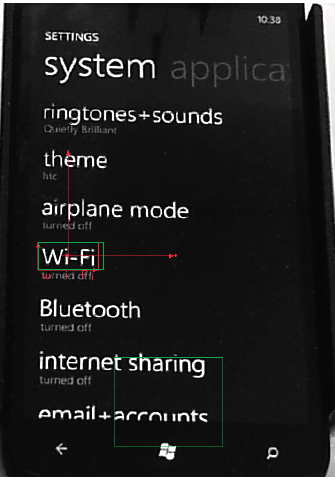
Figure 17. Recognition result with red characters: “Wi-Fi”.